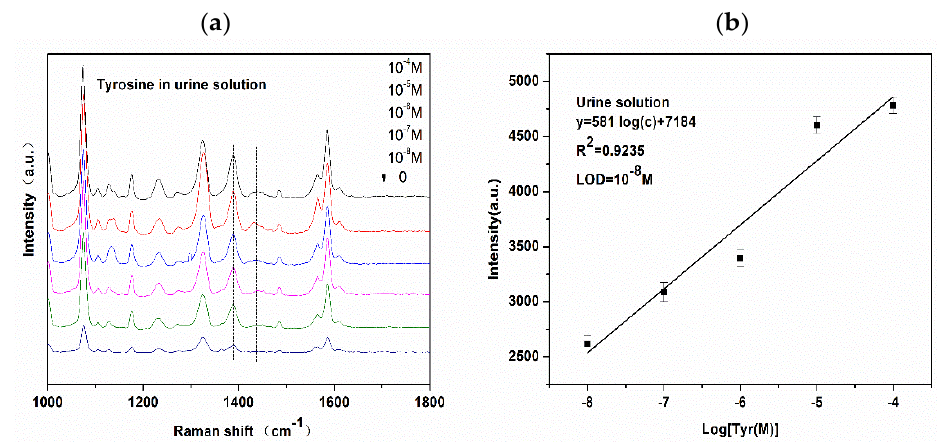
Figure 9. ( a ) SERS spectra of azo dye against various concentrations of Tyr in urine solution of normal human; ( b ) Intensity of the band at 1389 cm − 1 versus log concentration of Tyr in urine solution.